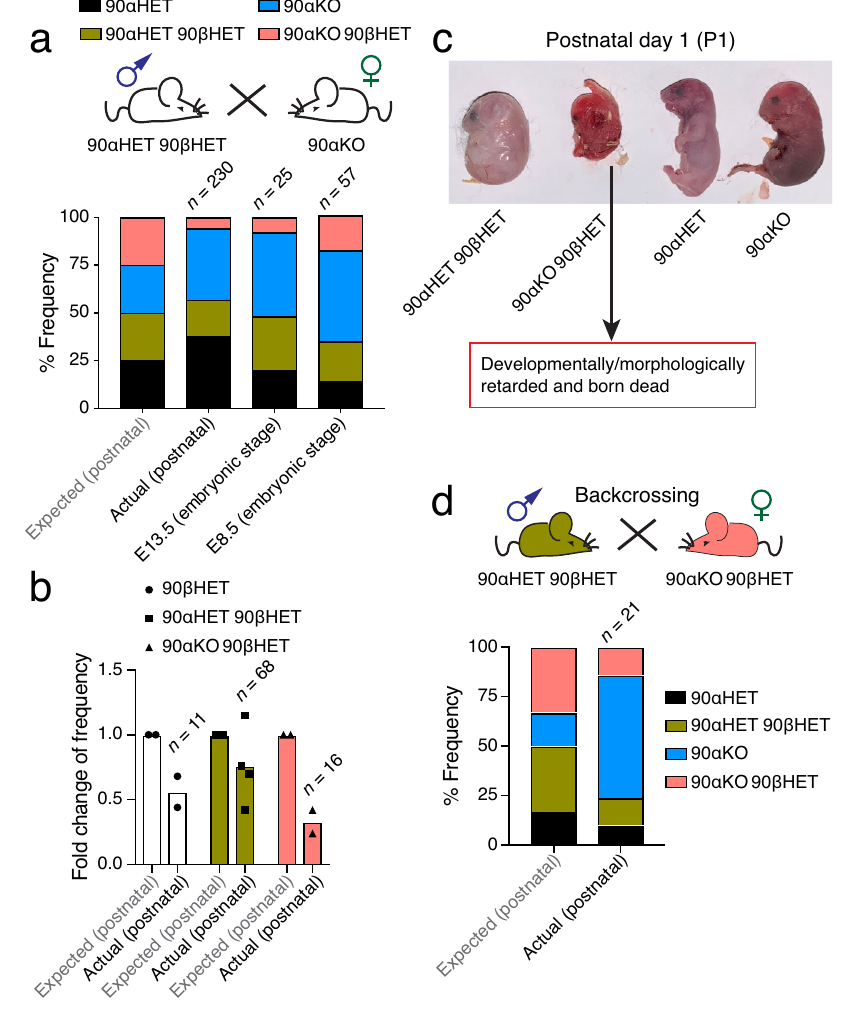
Fig. 1 | Segregation distortion in mice carrying variable numbers of Hsp90 alleles.a ExpectedMendelianinheritanceandobserved(actual)segregationinlive pups (postnatal) or embryos (E8.5 and E13.5) of the indicated genotypes from crossing90 α HET90 β HETand90 α KOmice.Onlyfemale90 α KOmicewereusedin thisbreedingstrategysincemalemiceoftheidenticalgenotypearesterile 39 . b Fold change of the expected and observed genotype frequencies forlive pups resulting from different breeding strategies illustrated in Supplementary Fig. 1c – g. The expected frequency of a particular genotype from a speci fi c breeding was set to 1. Each data point corresponds to a speci fi c breeding strategy that produced